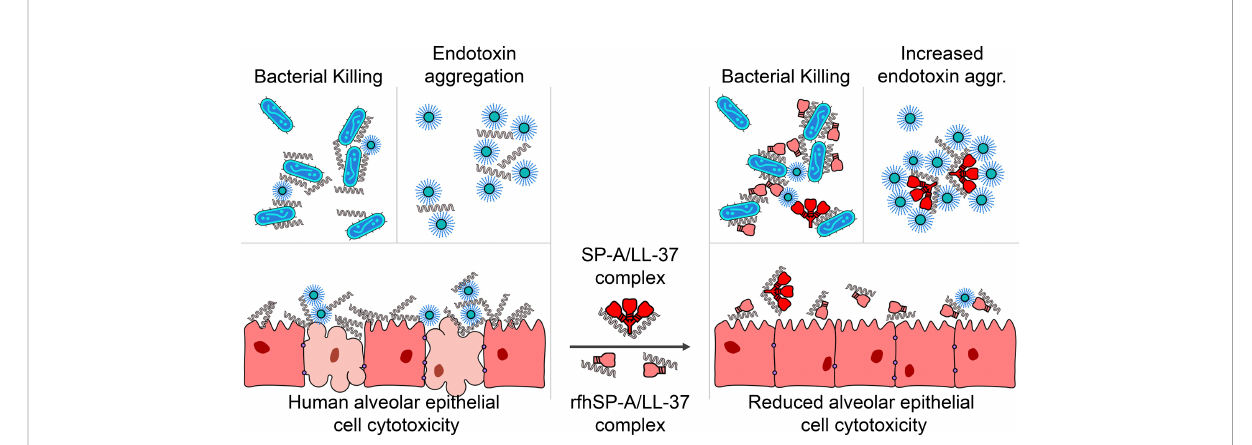
FIGURE 13 SP-A and rfhSP-A interact directly with LL-37. The LL-37 molecules integrated in the SP-A/LL-37 and rfhSP-A/LL-37 complexes are unable to induce membrane permeability in alveolar epithelial cells and the release of IL-8 by these cells, while retain or even enhance their antimicrobial properties against Gram-negative